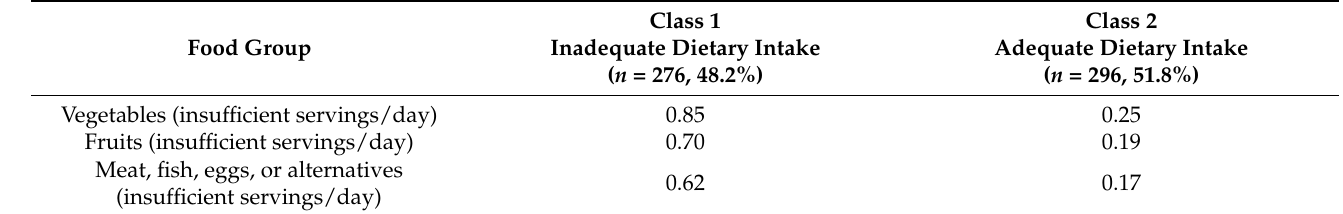
Table 3. Parameter estimates for each latent